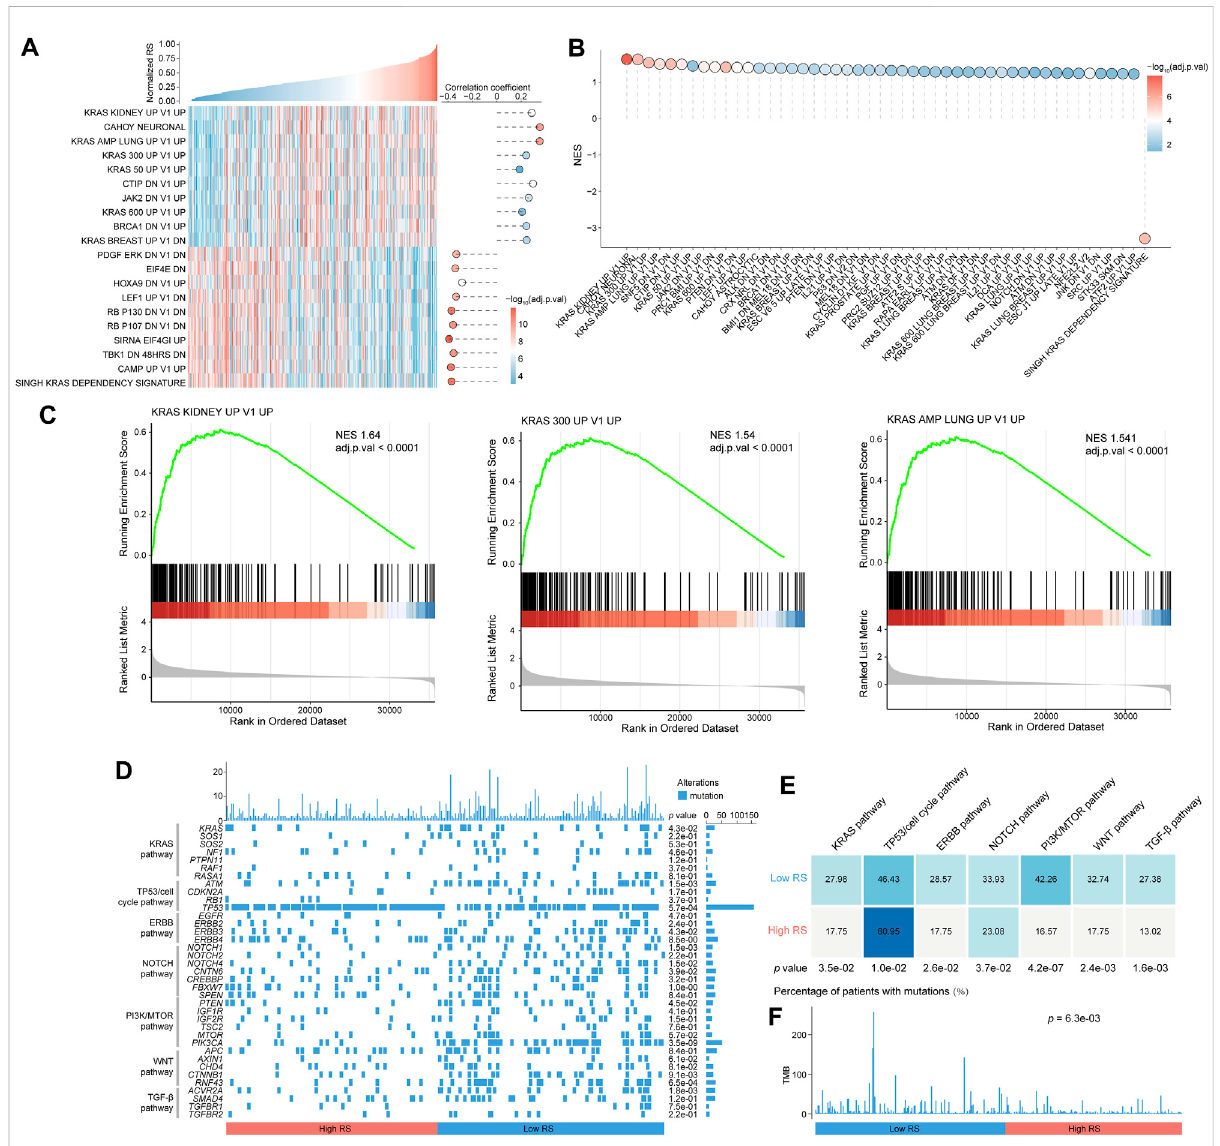
FIGURE 4 Signi fi cant difference of molecular characteristics in the two RS groups. (A) Overview of the association between RS and oncogenic signatures scored by GSVA. The correlation coef fi cient and signi fi cance are measured by using Pearson correlation analysis. (B) The result of GSEA shows high RS-associated and low RS-associated oncogenic signatures. (C) Three representative GSEA enrichment plots. (D) Oncoprint of mutation status of genes in several key pathways engaged in GC. Statistical signi fi cance of difference was analyzed using Chi-Square test or Fisher ’ s exact test. (E) Percentage of mutations in different pathways betweentwo RS groups. (F) TMB inthe twoRS groups. Chi-Square testwas used to achieve statistical analysis. RS, risk score; GSVA, Q14 gene set variation analysis; GSEA, gene set enrichment